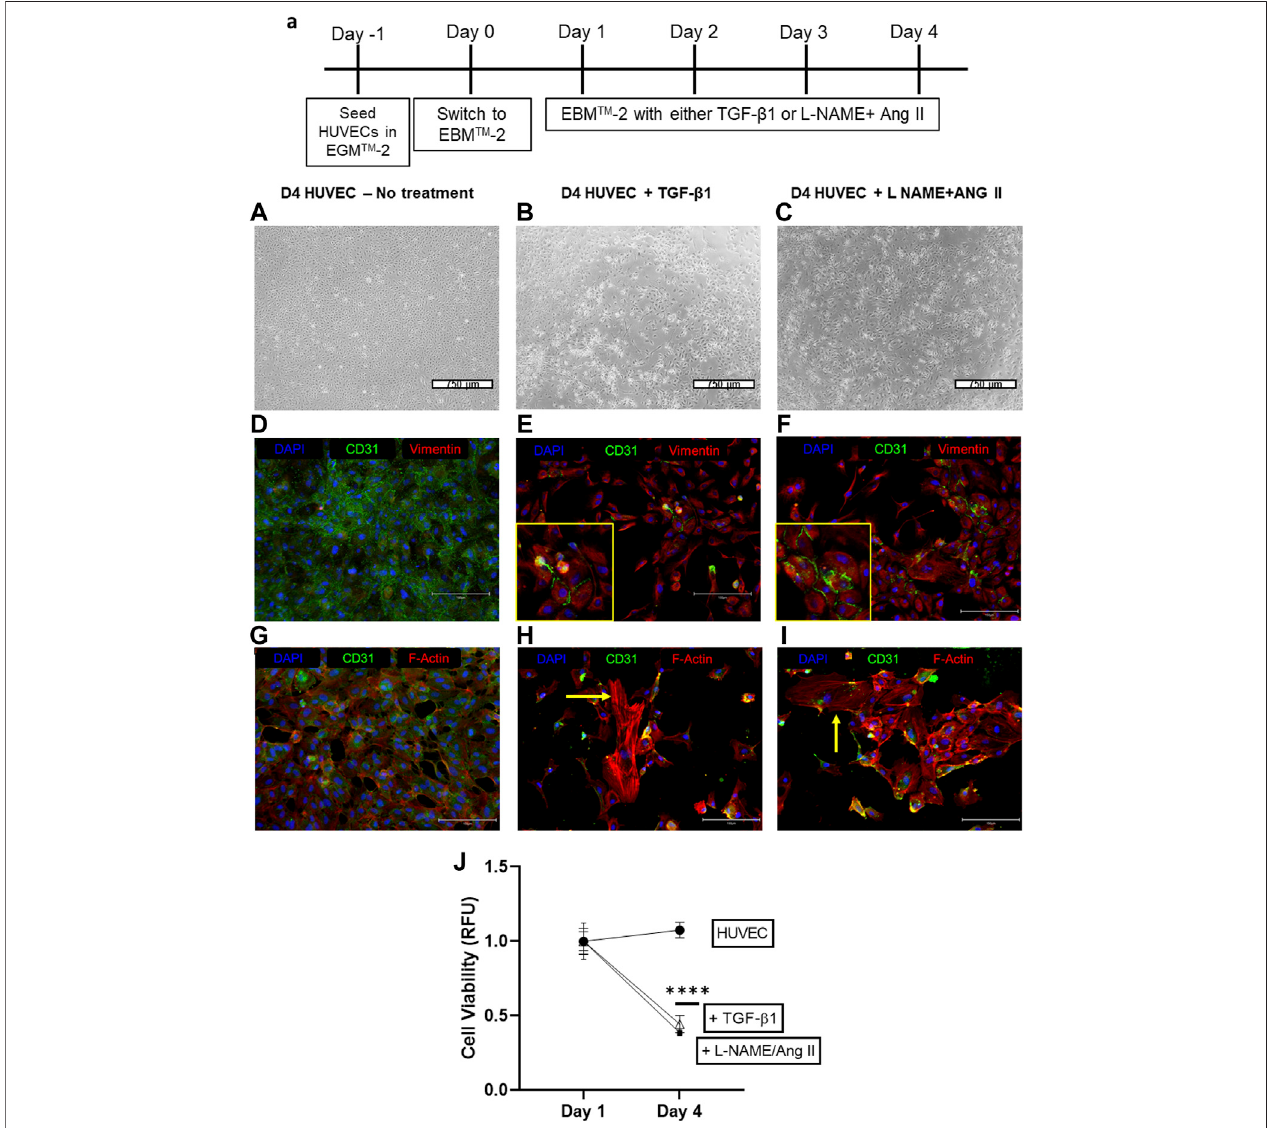
FIGURE 2 | Induction of EndoMT in HUVECs cells by TGF- β 1 or L-NAME + Ang II. (A) Representative scheme for EndoMT (A – C) Representative images of morphological changes of HUVECs after TGF- β or L-NAME + Ang II treatment; Scale bar: 750 μ m; (D – F) Representative images exhibiting the presence of CD31 and Vimentinpositivecells indicatingthe EndoMT process; Yellow insetsrepresent thezoomed-inregionswith CD31 + and Vimentin +cells thatindicate EndoMT; Scale bar: 150 µm (G – I) Representative images demonstrating F-actin reorganization of HUVECs during TGF- β /L-NAME + Ang II treatment; Yellow arrows indicate actin reorganization in the form of stress fi bers; Scale bar: 150 µm (J) Cell viability was measured using the alamarBlue assay at different time points during EndoMT.